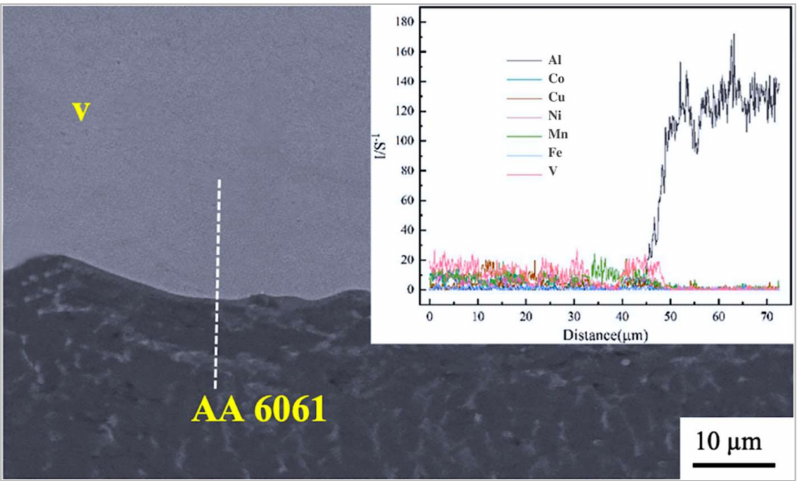
Figure 6. Weld interface SEM image (from area C in Figure 2). v is the areas where EDS performed.